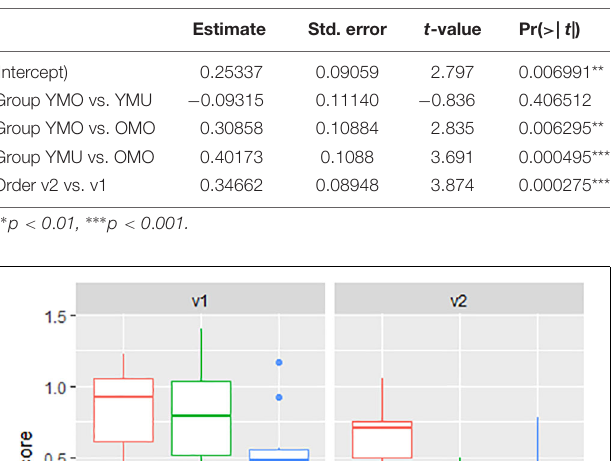
TABLE 6 | Summary statistics of the linear model with D -score as dependent variable and the influencing factors listener group and test order for the